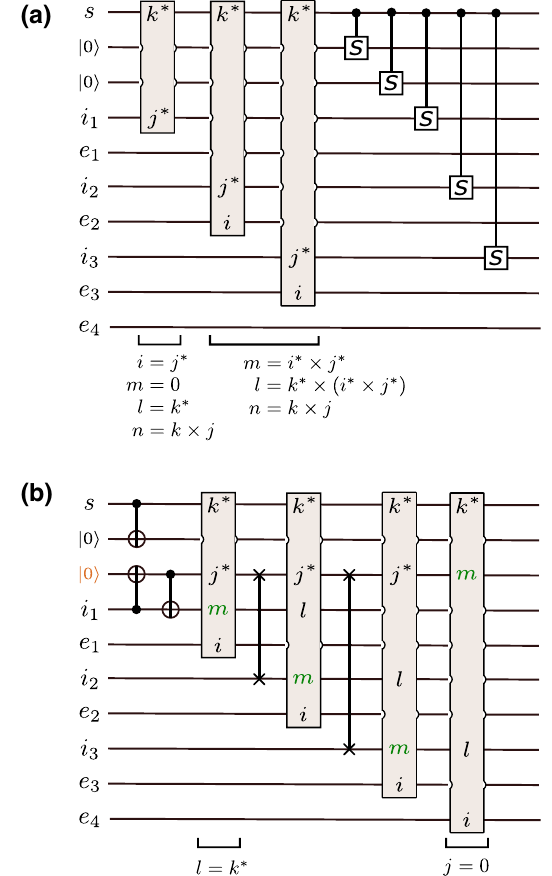
FIG. 17. Explicit circuit diagrams for Fig. 16. The qudits are labeled by Eq. (E1). (a) The C- ˆ B p for the Abelian case. Here, we use the controlled fusion gate C- S , which performs the unitary C- S | s , i (cid:3) = | s , s × i (cid:3) . (b) The circuit for the non-Abelian case; the qudit used to store the ancillary state is marked in